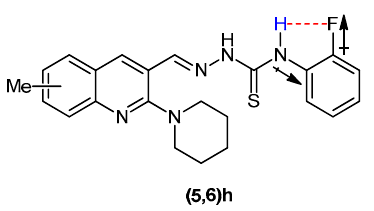
Figure 2. Deshielding of Ar-NH in compounds 5h and 6h